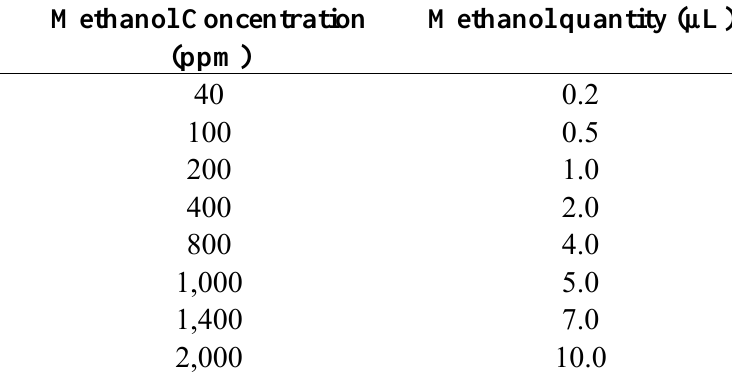
Table 2. Methanol concentration vs. methanol quantity.